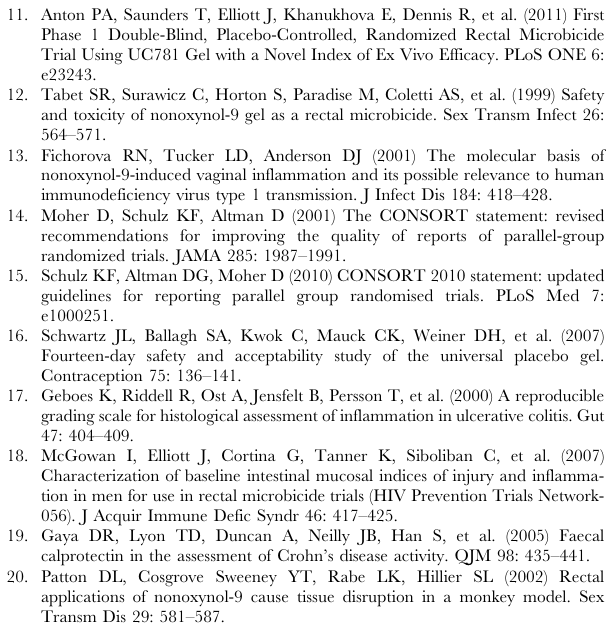
Table S1 qRT-PCR primer and probe sequences. Table S2 Study retention and